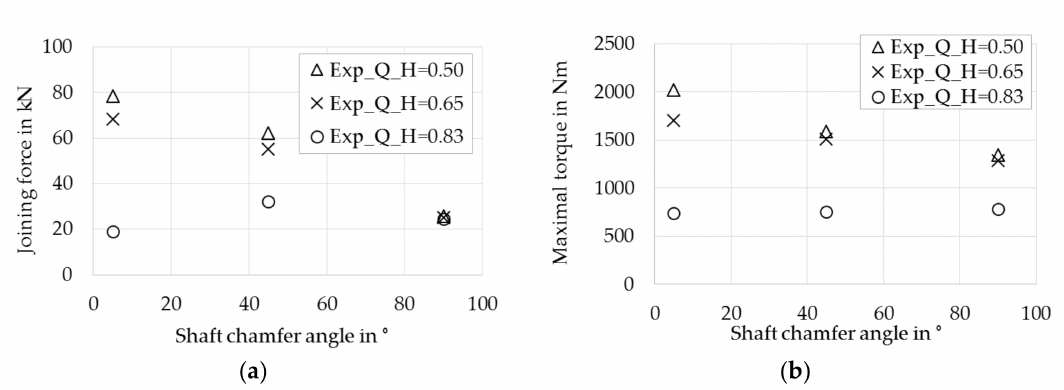
Figure 3. Results from hub-diameter ratio and shaft chamfer angle testing, ( a ) maximum joining force; and ( b ) maximal torque